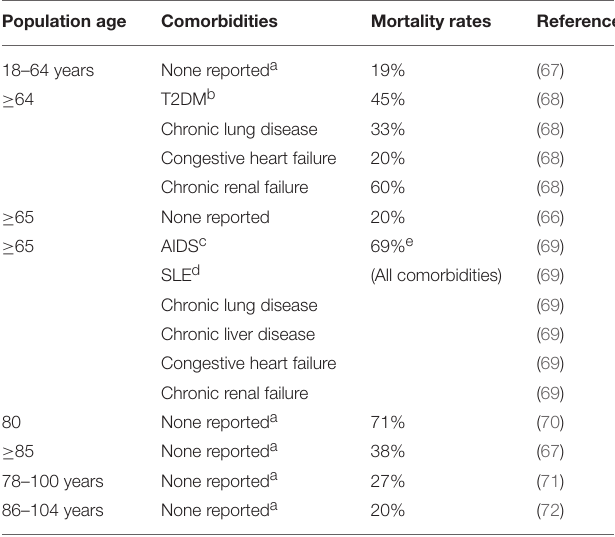
TABLE 1 | Effect of age and comorbidities on mortality rates after pneumococcus infection. Population